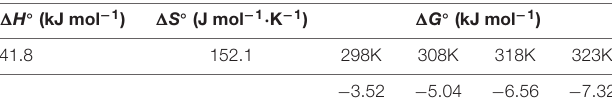
TABLE 4 | Thermodynamic parameters for uranium adsorption on TiO 2